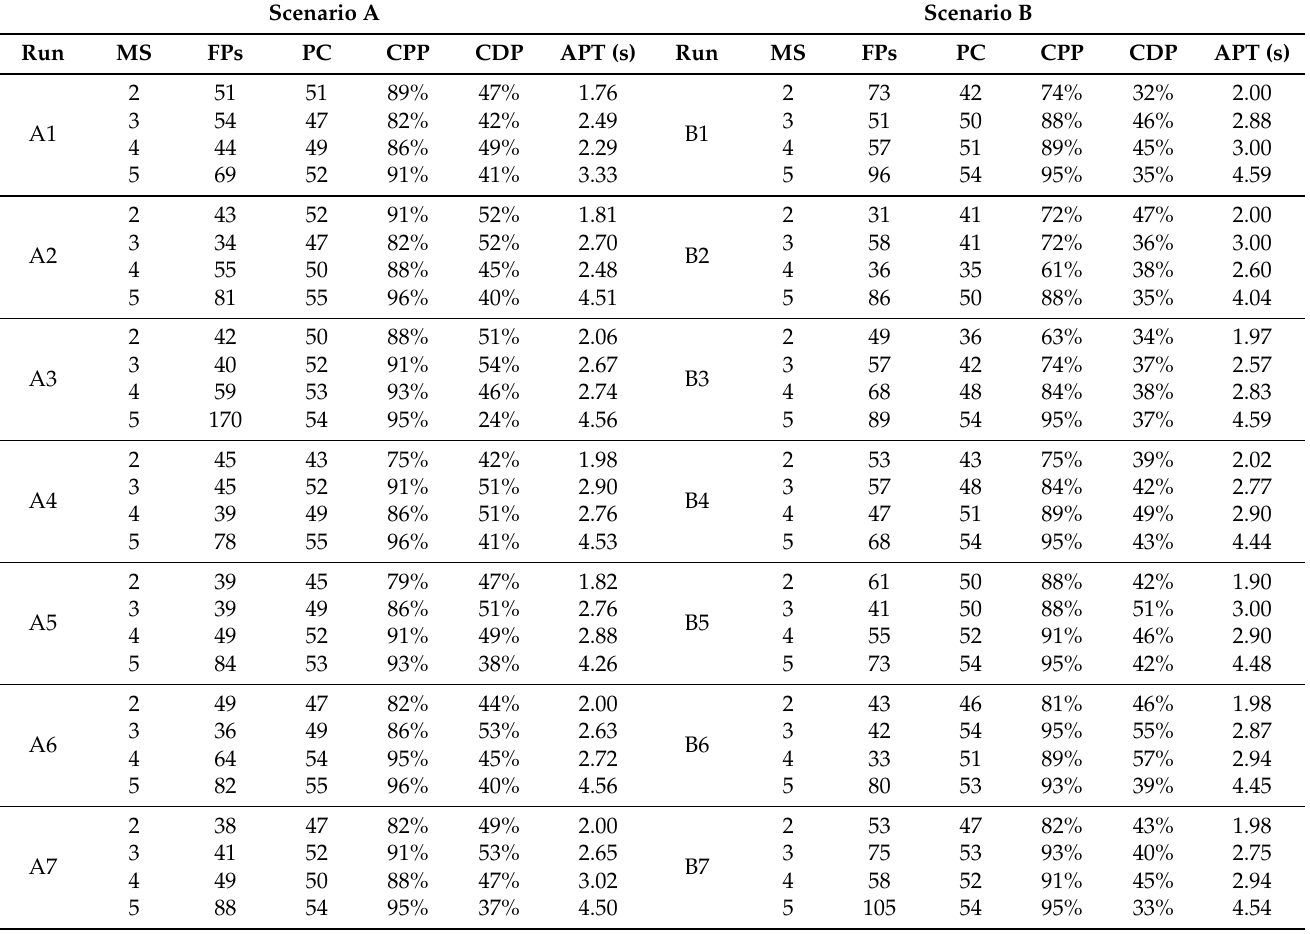
Table 4. MS Forecast Results. Legend: MS—Multiple steps; FPs—False Positives; PC—Predicted Collisions; CPP—Collision Prediction Percentage; CDP—Correct Decision Percentage; APT—Average Prediction Time (s).